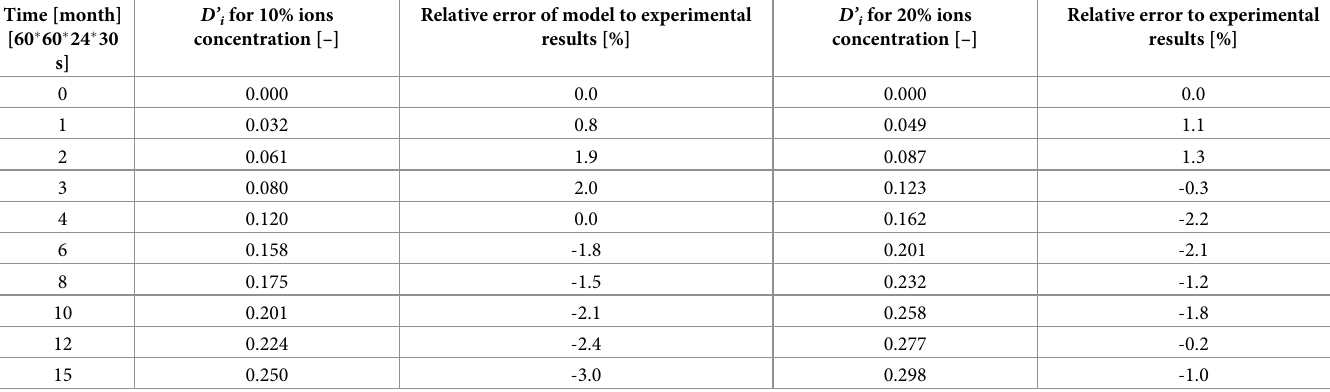
Table 3. The results of experimental research based on [22] and relative error for the proposed model. Time [month] [60 � 60 � 24 �